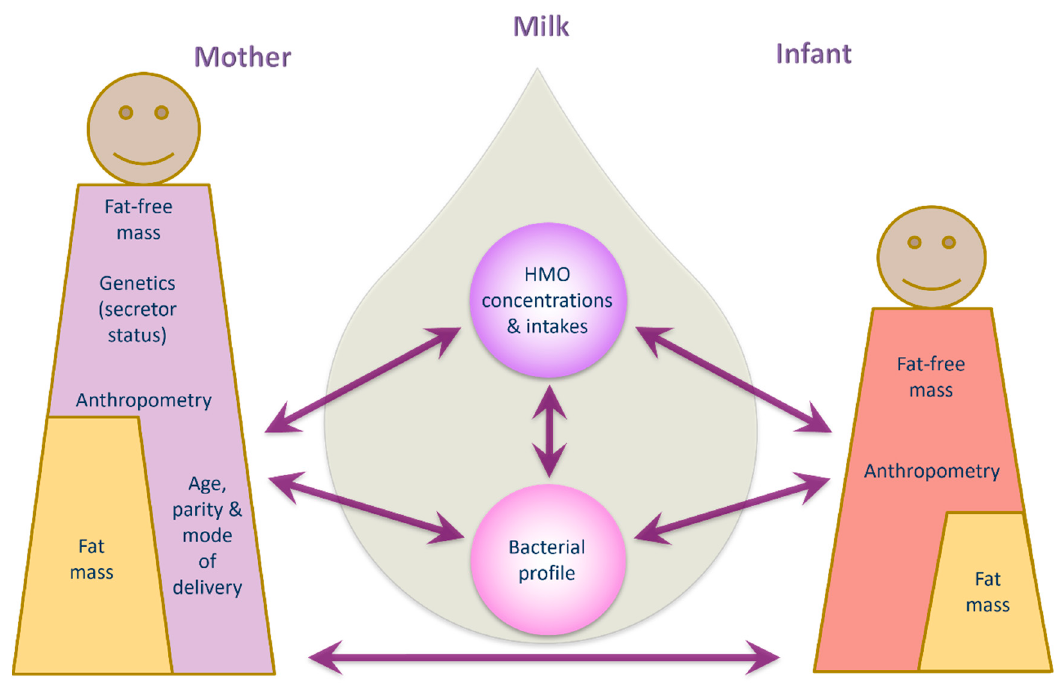
Figure 4. Potential interconnecting pathways of lactocrine programming of infant body composition.